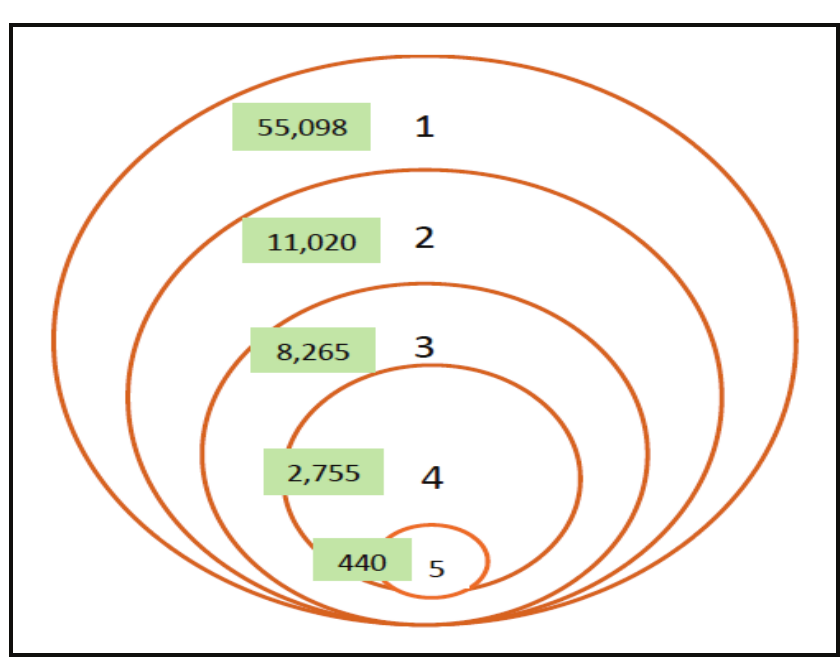
Figure 1: Crude estimation of COVID-19 cases in Sudan if mitigation efforts are put in place*. 1: Asymptomatic or mild symptoms, but not tested; 2: Estimated patients tested positive for COVID-19; 3: Cases need hospitalization; 4: Patients who need ICU care; 5: *Projected number of mortality. *These estimated numbers are based on the WHO COVID-19 Essential Supplies Forecasting Tool [20]. *The estimated mortality rate depends on the case fatality rate (CFR = 4.0%).